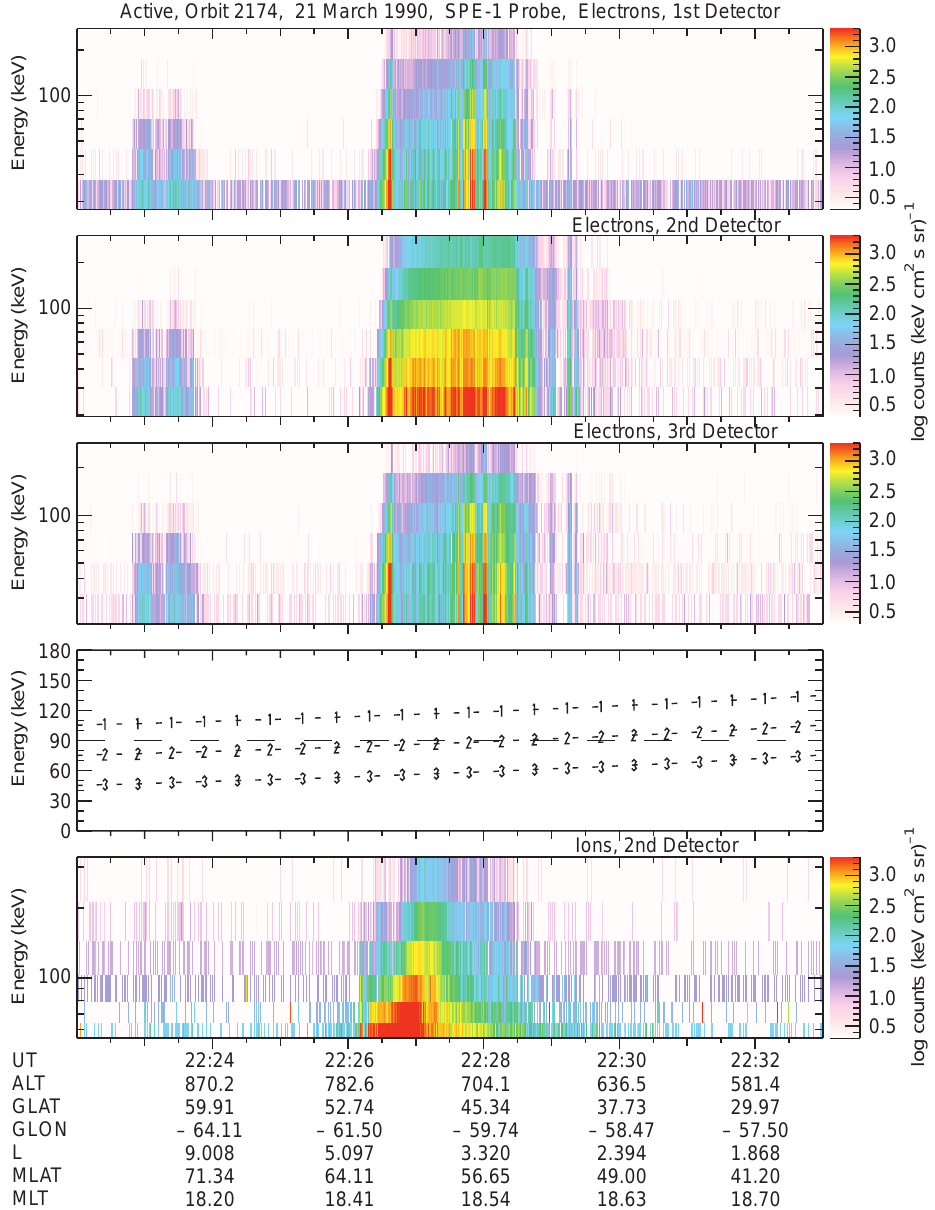
Fig. 7. SPE-1 energetic electron ( upper three panels ) and ion ( bottom ) spectra measured with three di(cid:128)erent detectors whose pitch angle orientations are given in the fourth panel . At the abscissa are shown the satellite’s altitude ( ALT ), geographic lati- tude ( GLAT ) and longitude ( GLON ), the L -value, geomag- netic latitude ( MLAT ) and the magnetic local time in decimal hours (